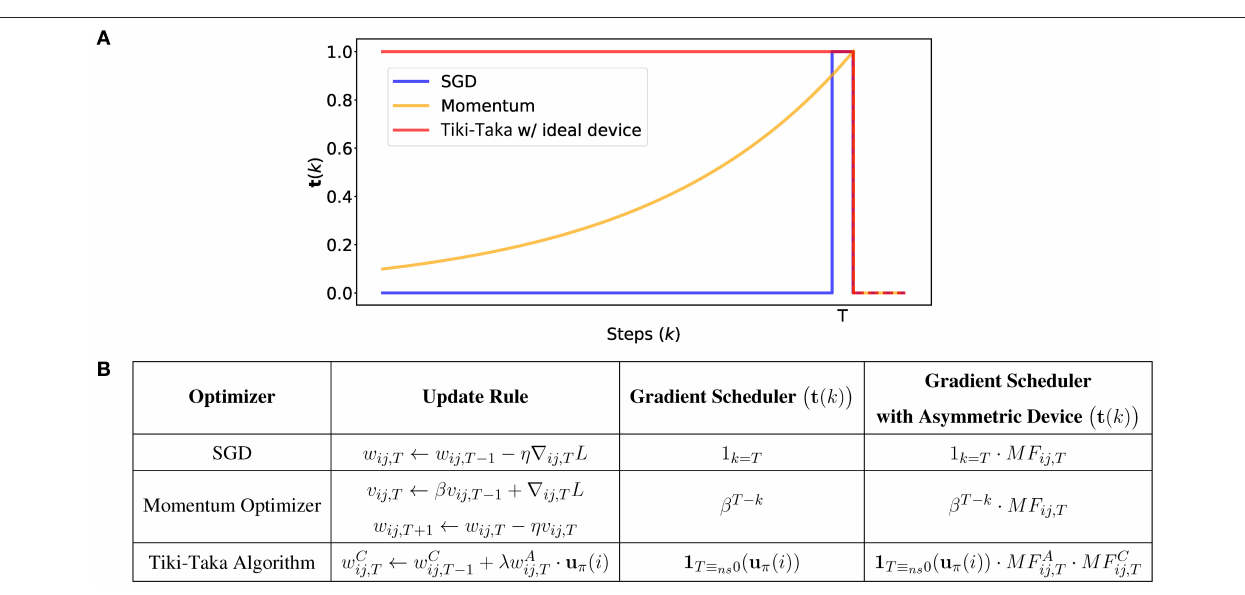
FIGURE 3 | (A) Comparison of gradient scheduler, t ( k ), of SGD, momentum-based optimizer, and Tiki-Taka algorithm with respect to steps, k. t ( k ) is normalized by the value of t ( T ). (B) Summarized table of gradient scheduler of optimizers from (A)